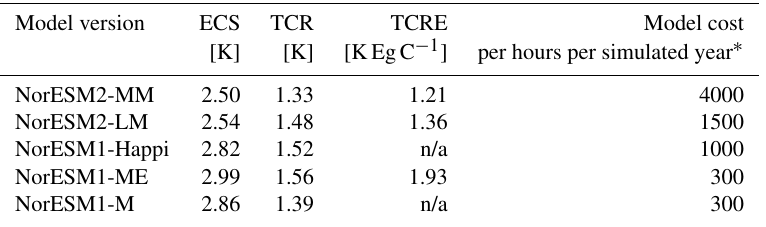
Table 1. Climate sensitivities of NorESM2-LM and NorESM2-MM compared to NorESM1 model versions: equilibrium climate sensitivity (ECS), transient climate sensitivity (TCR), and transient climate response to cumulative carbon emissions